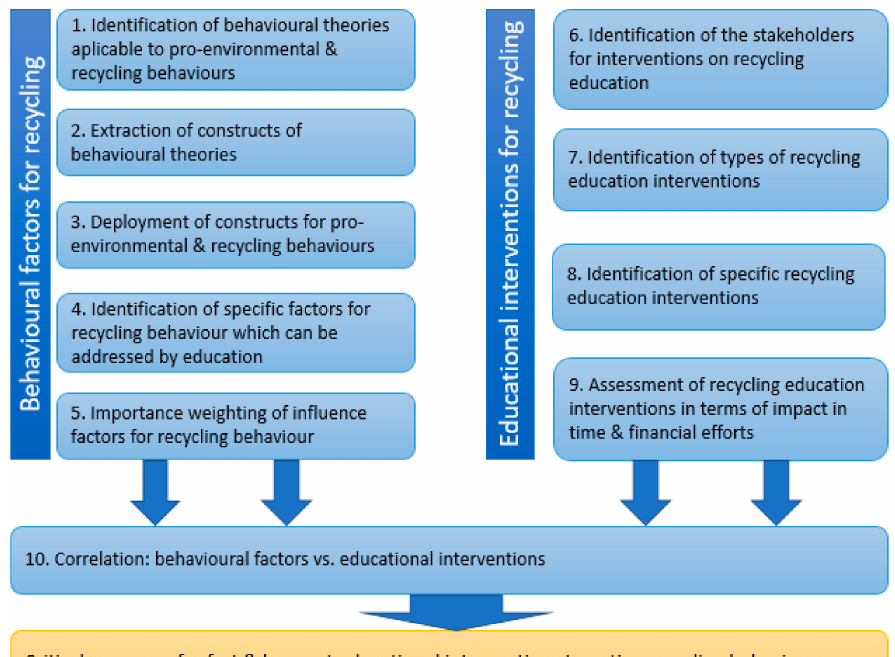
Figure 1. Research